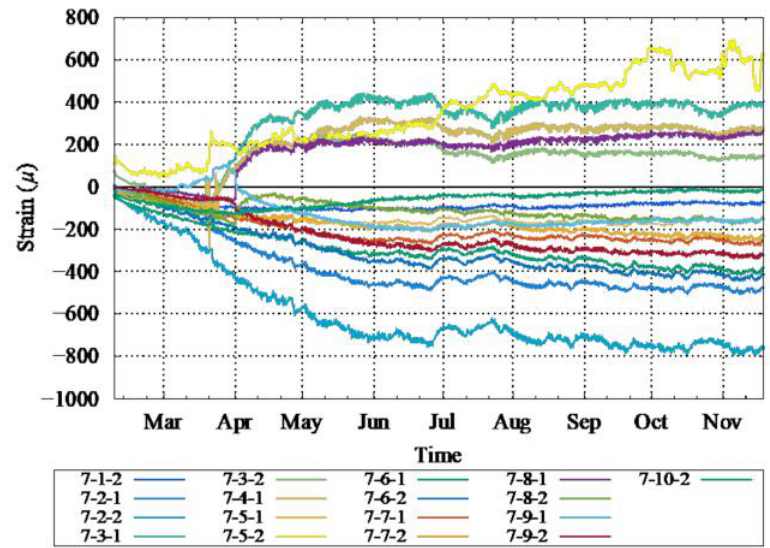
Figure A2. Development of strain in the dried specimen.